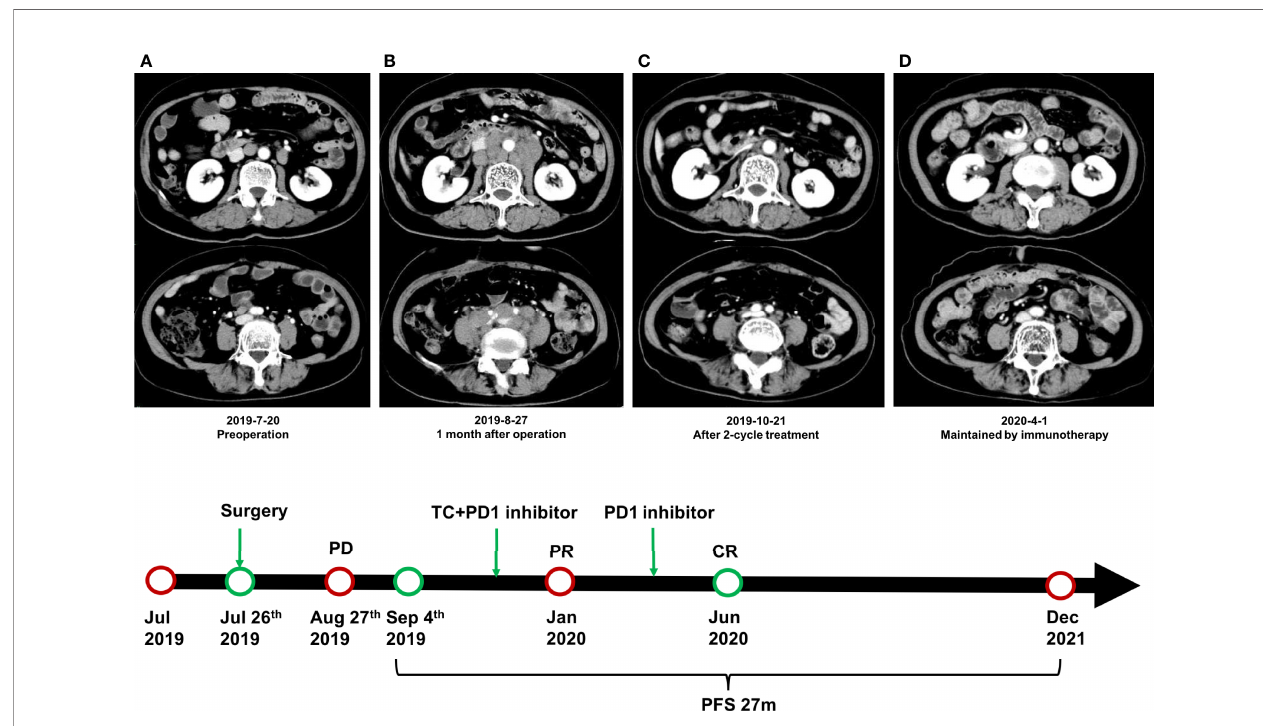
FIGURE 3 | Radiographic fi ndings during the treatment. (A) CT scan of the posterior peritoneum before surgery. (B) Multiple enlarged and merged lymph nodes were found in the posterior peritoneum at 1 month after surgery. (C) The lesions were obviously shrunk and evaluated as partial response after 2 cycles of combined treatment. (D) The disease achieved complete response during the consolidation treatment of